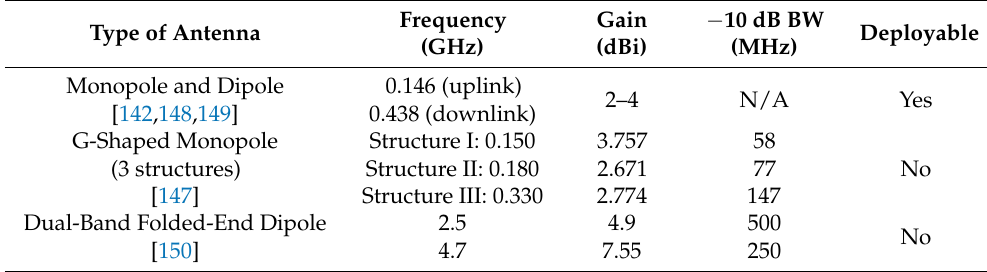
Table 6. Performance of monopole and dipole